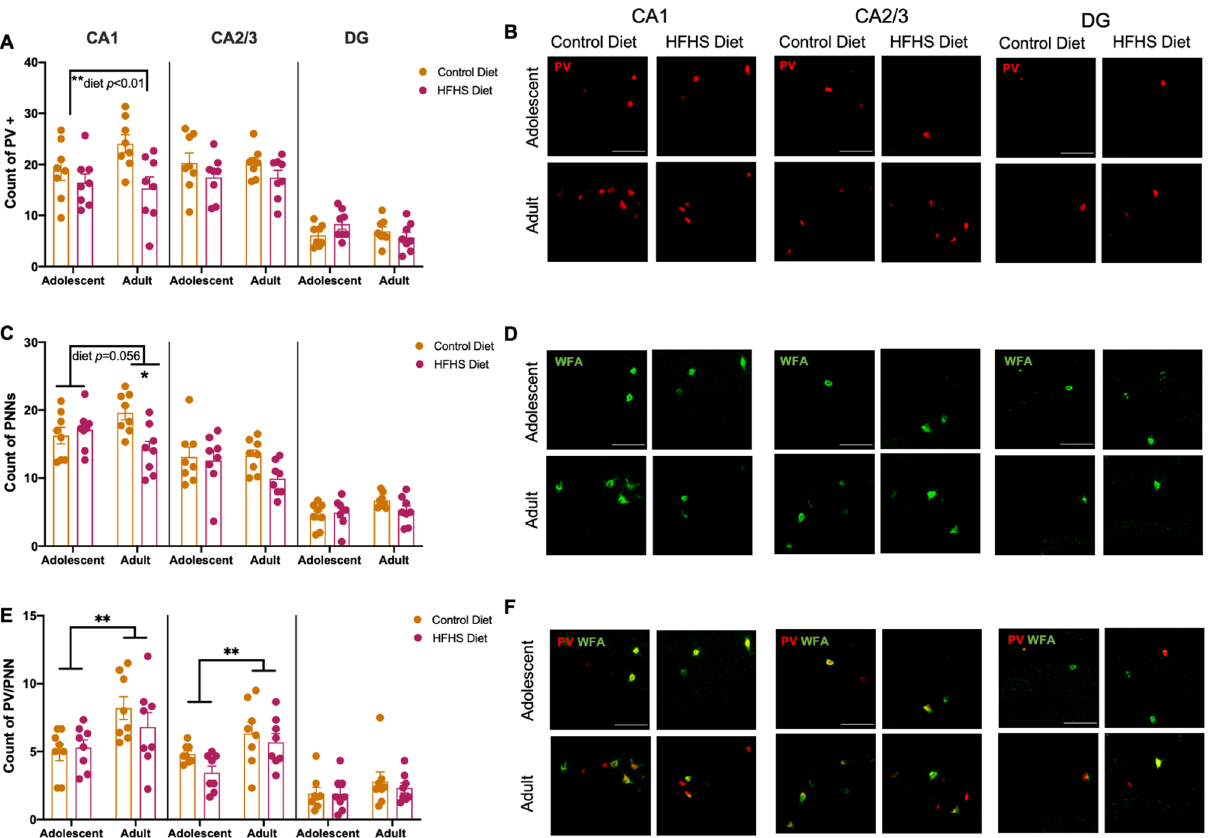
Figure 3. Age and HFHS diet effects on hippocampal subregions. Mice that consumed HFHS diet had fewer ( A , B ) PV+ neurons in CA1, but not CA2/3 or DG. Adult mice that consumed HFHS diet had fewer PNNs in the CA1, however no group differences were seen in the CA3 or DG ( C , D ). There were significantly more PV/ PNN colocalised neurons in the adult cohort ( E , F ) in the CA1 and CA2/3, but not DG. Data were assessed using two-way ANOVAs * p < 0.05, ** p < 0.01. Representative photomicrographs were taken at 40X magnification (red—parvalbumin, green—WFA + PNN), scale bars show 100